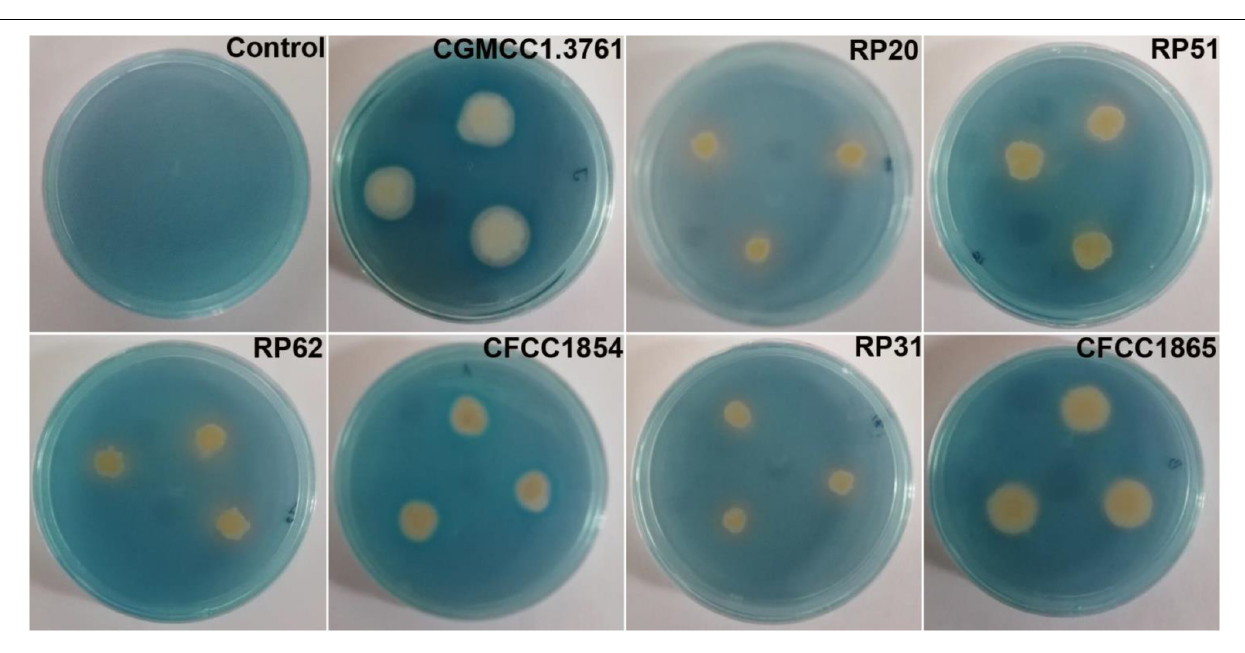
gene clusters for biosynthesis of fusaricidins and siderophores ( Supplementary Table 1